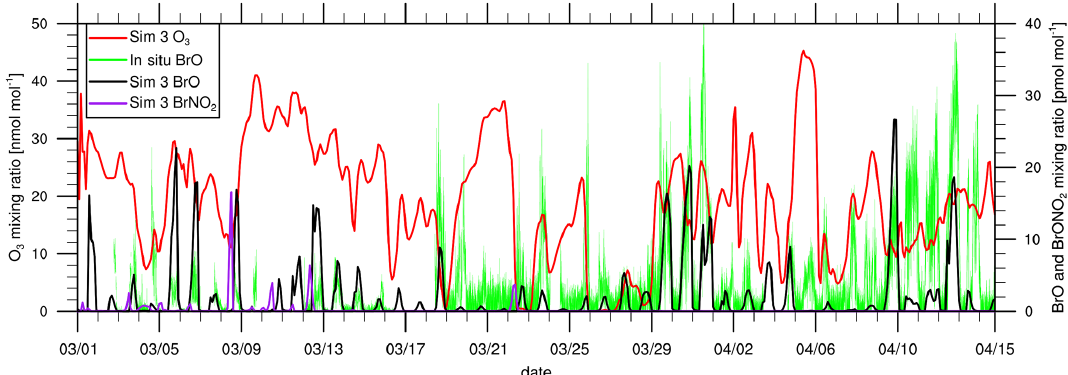
Figure 7. Comparison of modeled BrO and in situ observations of BrO at Utqia˙gvik (Liao et al., 2011) and modeled O 3 and BrNO 2 ; the numerical results are for simulation 3. The data are shown at 00:00GMT +